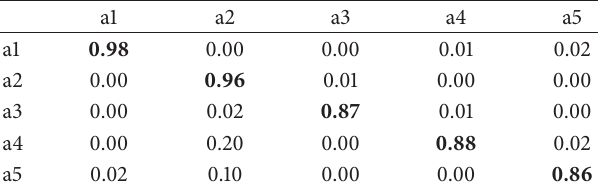
Table 4: Confusion matrix for our dataset.